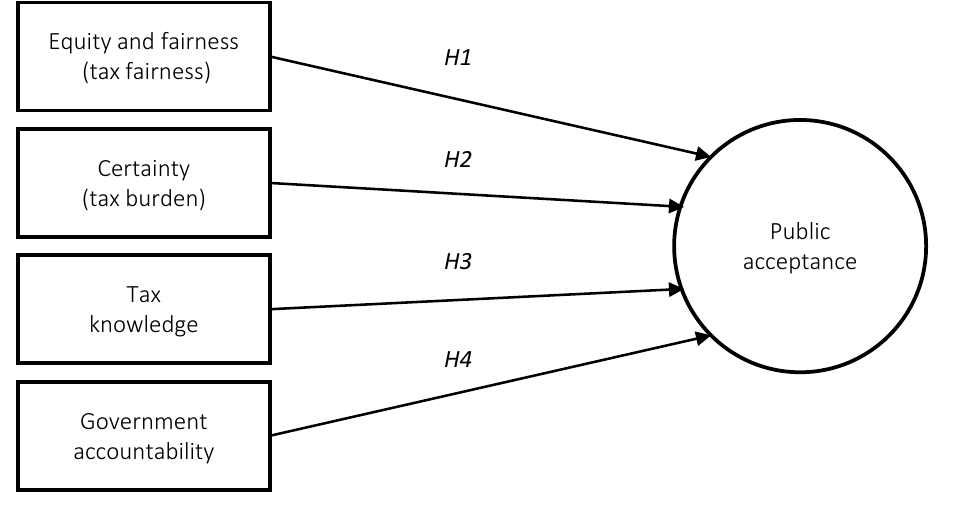
Figure 1. Conceptual framework and hypotheses development of the